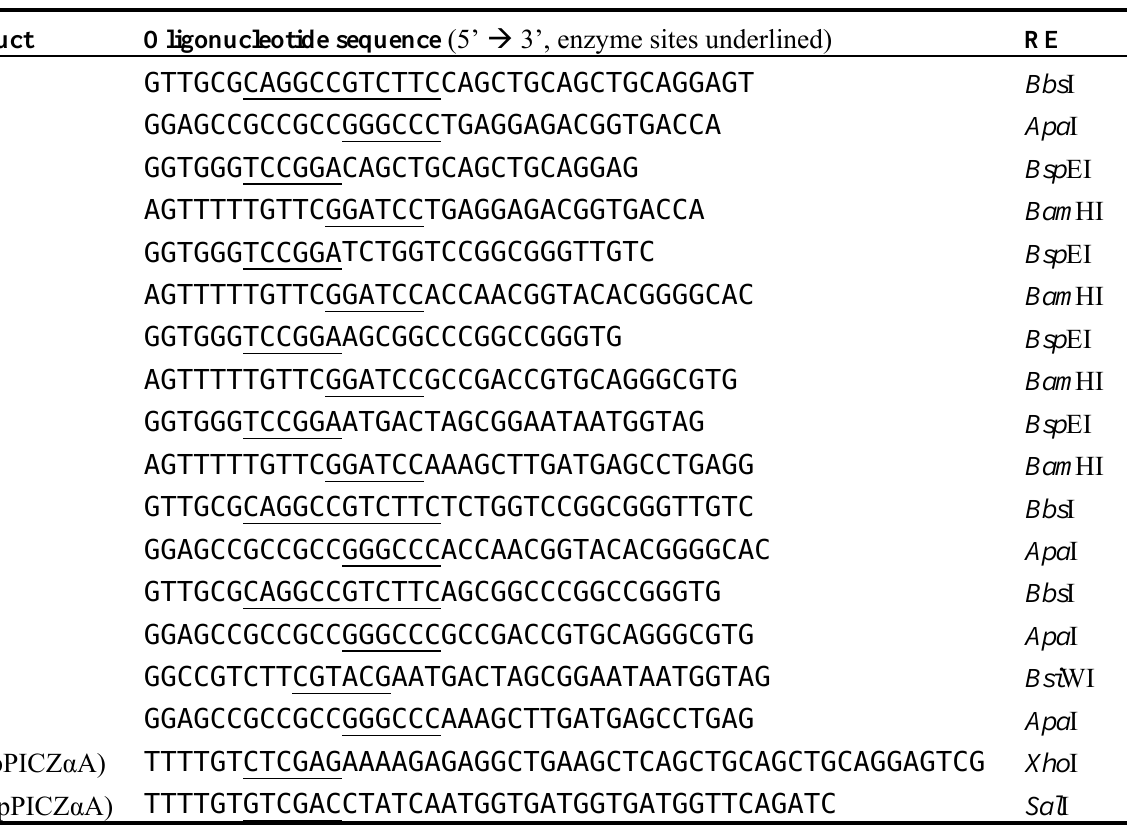
Table 1. Oligonucleotides used in the assembly of expression